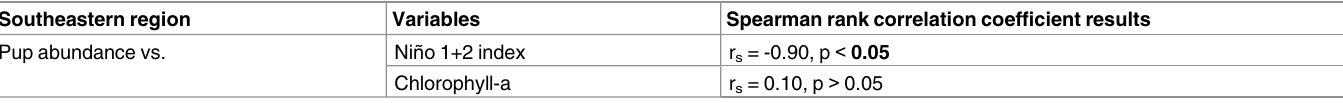
Table 3. Spearman’srank correlation coefficient results. Relationships betweenpup abundancein the southeastern regionand environmental variables from 2011to 2015; significantvalues are shown in bold. Southeastern region Variables Spearman rank correlation coefficient results Pup abundance